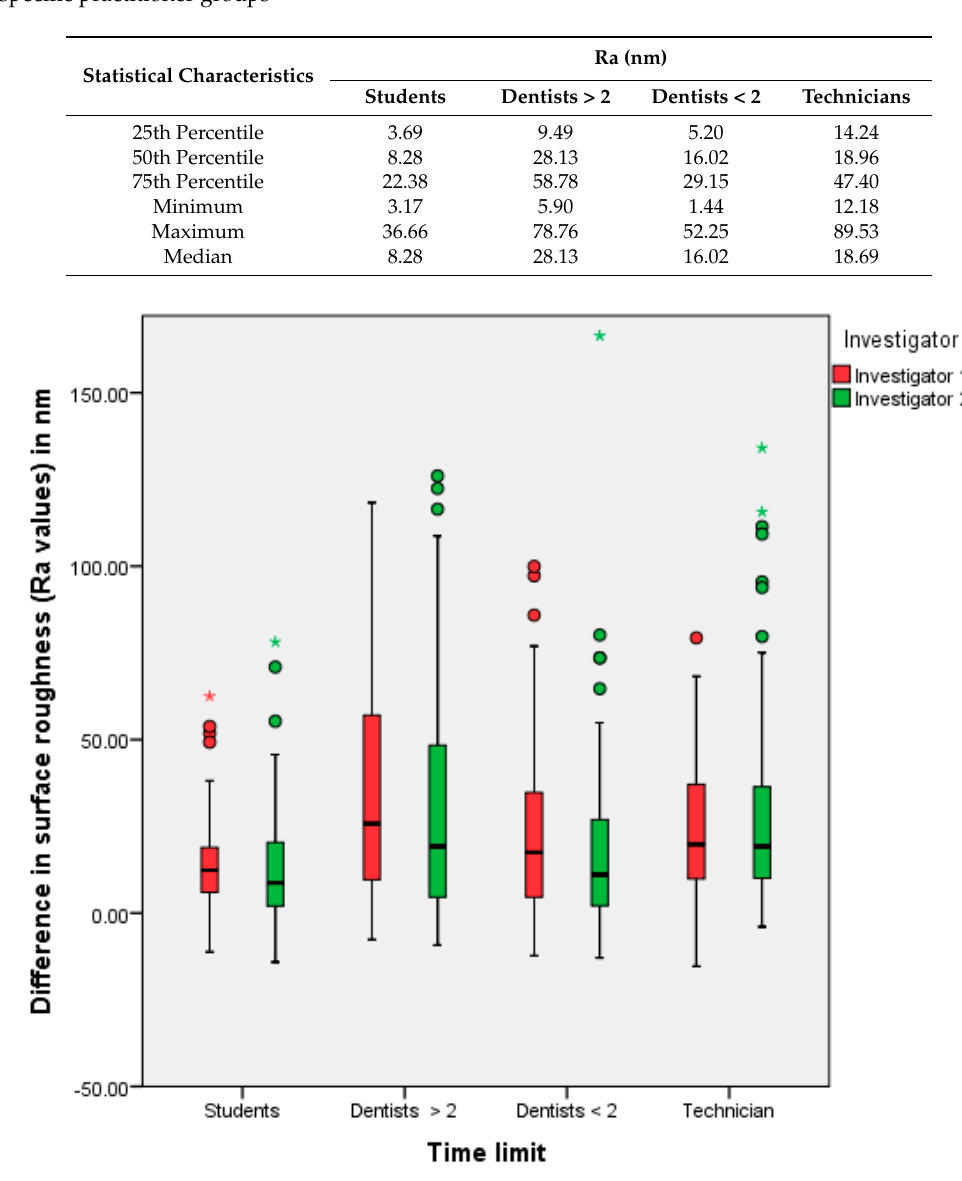
Figure 2. Polishing results (=differences between the Ra values before and after polishing) of the different practitioner groups, investigators one and two/second trial (* extreme values, • outliers).